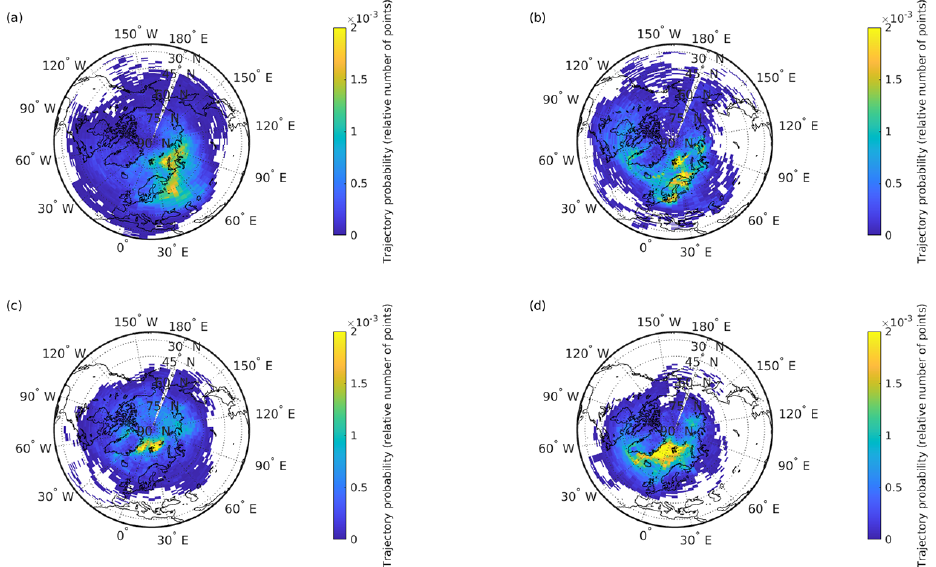
Figure 3. The 10d backward trajectory probability maps for the air masses originating from a source area boundary layer and arriving at 0–500m above the region of interest in Svalbard. The trajectories’ points corresponding to the first day of the simulation are not considered since most of the points for this day are over the Svalbard region. Data are for the November–January P1 (a) , February P2 (b) , March–April P3 (c) , and May–June P4 (d)